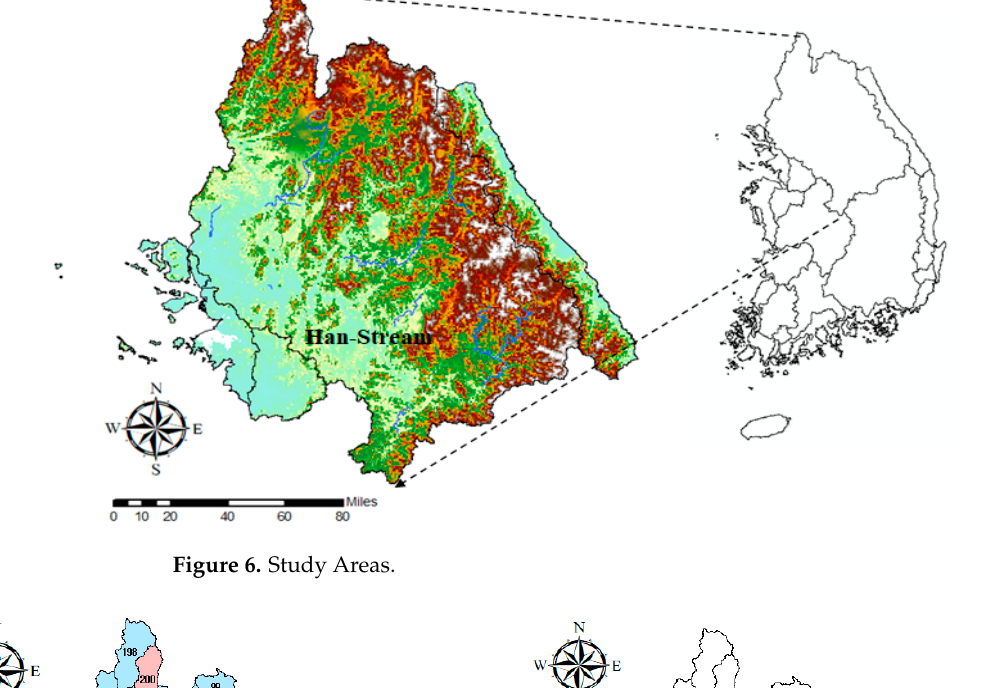
Figure 6. Study Areas.